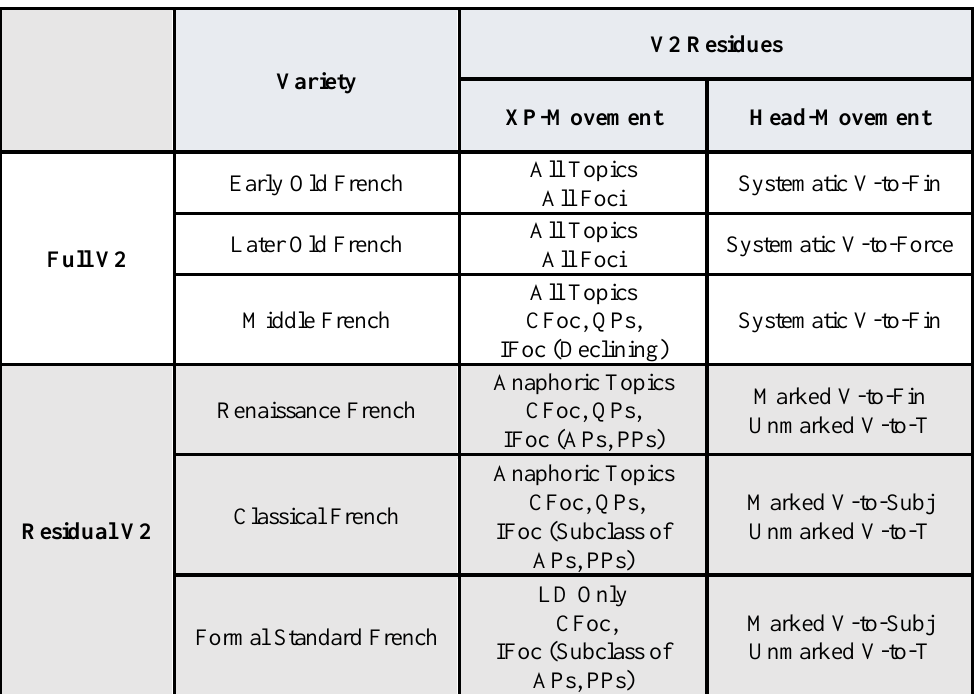
Table 3. V2 Residues in Varieties of